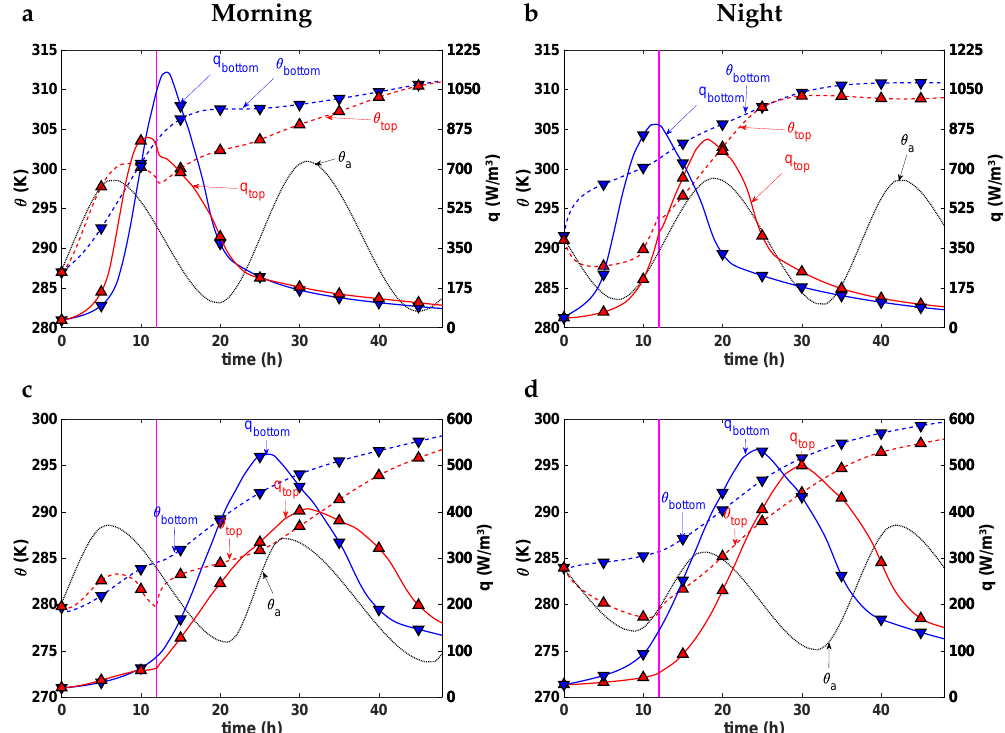
Figure 3. Here we illustrate the influence of the weather conditions on the heat hydration. We have simulated the construction of an RCC dam starting at two different times: on 1 April 2014, (first row), and 1 October 2014, (second row). The construction processes last 165 days and take place in spring and autumn, respectively. The evolution of the concrete temperature is represented by the dashed lines, the heat generation rate by the solid lines, and the ambient temperature by the dotted line. Red lines represent the evolution of points situated at the top of the considered lift, and blue lines—those at the bottom. Panel ( a ) includes the evolution of the points situated in the lift at 22.8 m height and built on 8 May 2014, at 8 a.m.—spring morning; and panel ( b ) represents sparse points of the lift at 21.9 m height and built on 6 May 2014, at 8 p.m.—spring night. Similar results are presented for the dam construction starting on October, 2014; panel ( c ) depicts the evolutions of the points in lift at 22.8 m height and built on 7 November 2014, at 8 a.m.—autumn morning. ( d ) The points in the lift at 21.9 m height and built on 5 November 2014, at 8 p.m.—autumn